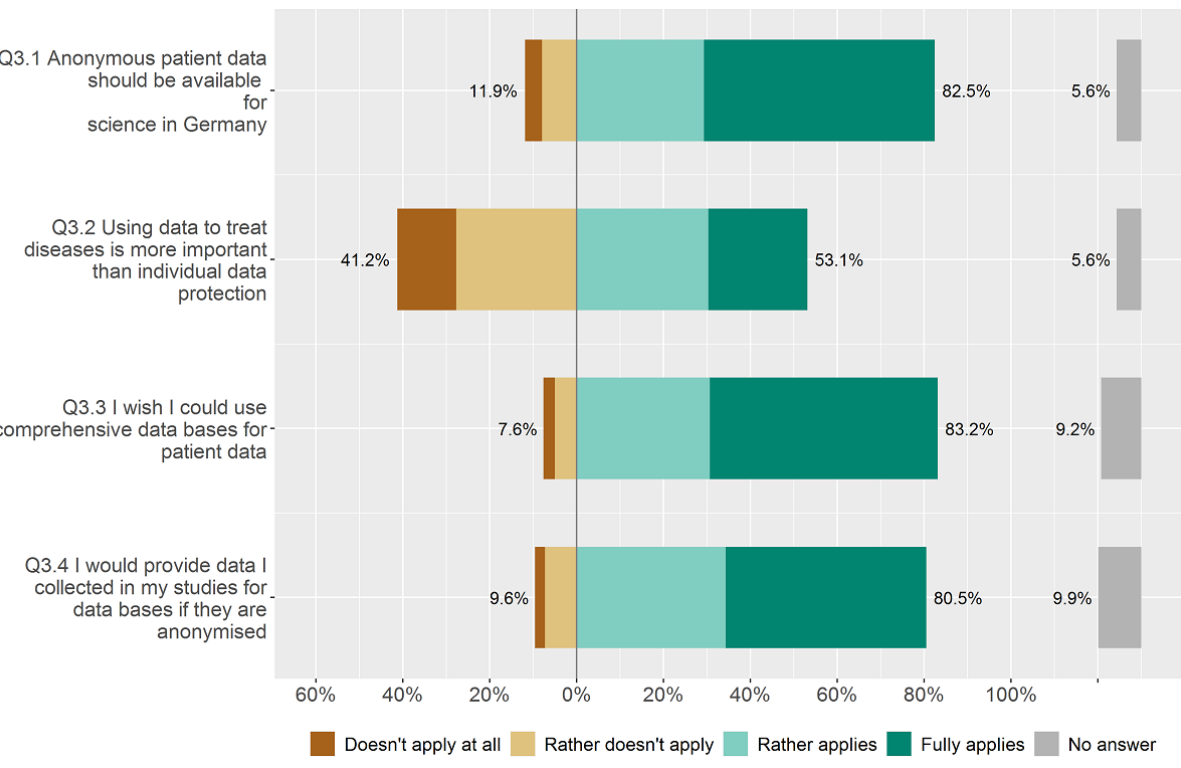
Figure 6. Attitude on the usage of (anonymized) patient data for medical